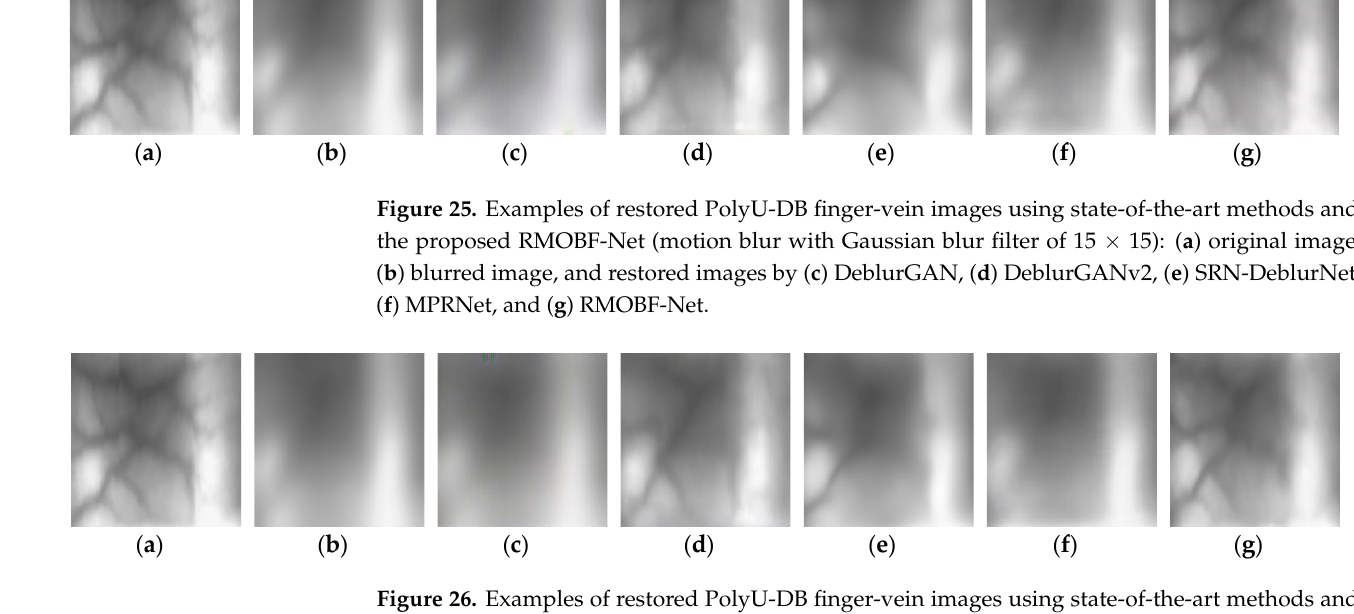
Table 8. Finger-vein recognition error (EER) comparison according to motion and optical blur application in PolyU-DB (unit: